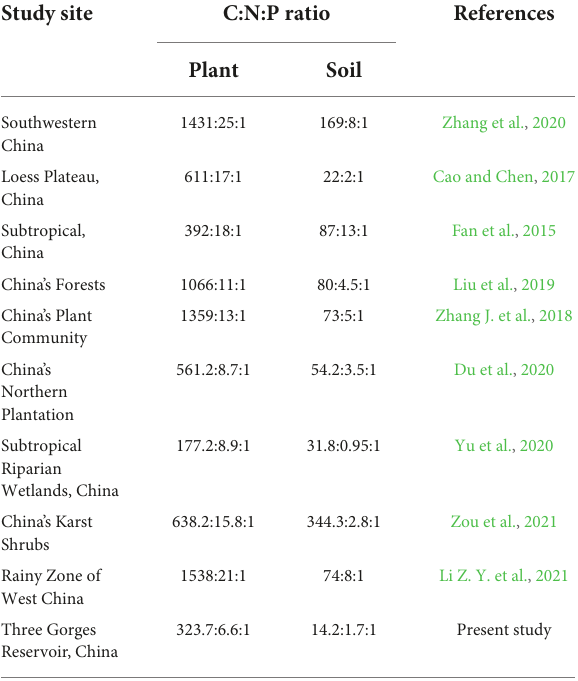
TABLE 1 Details of plant-soil stoichiometry reported in